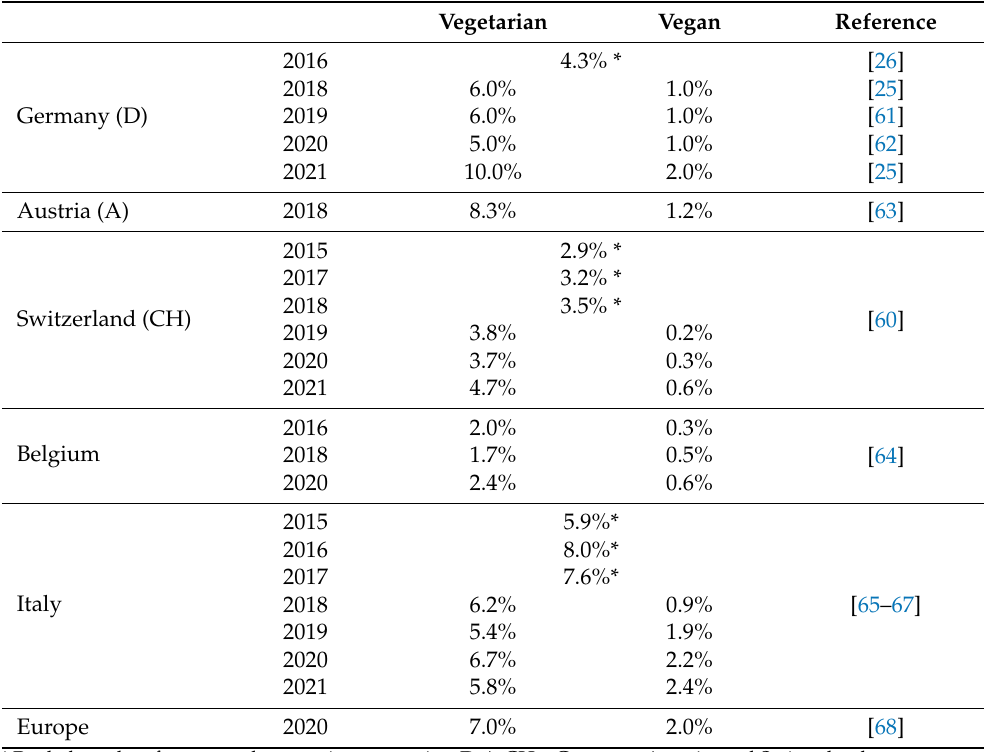
Table 5. The prevalence of vegan/vegetarian diets in D-A-CH countries and two other German- associated countries compared to